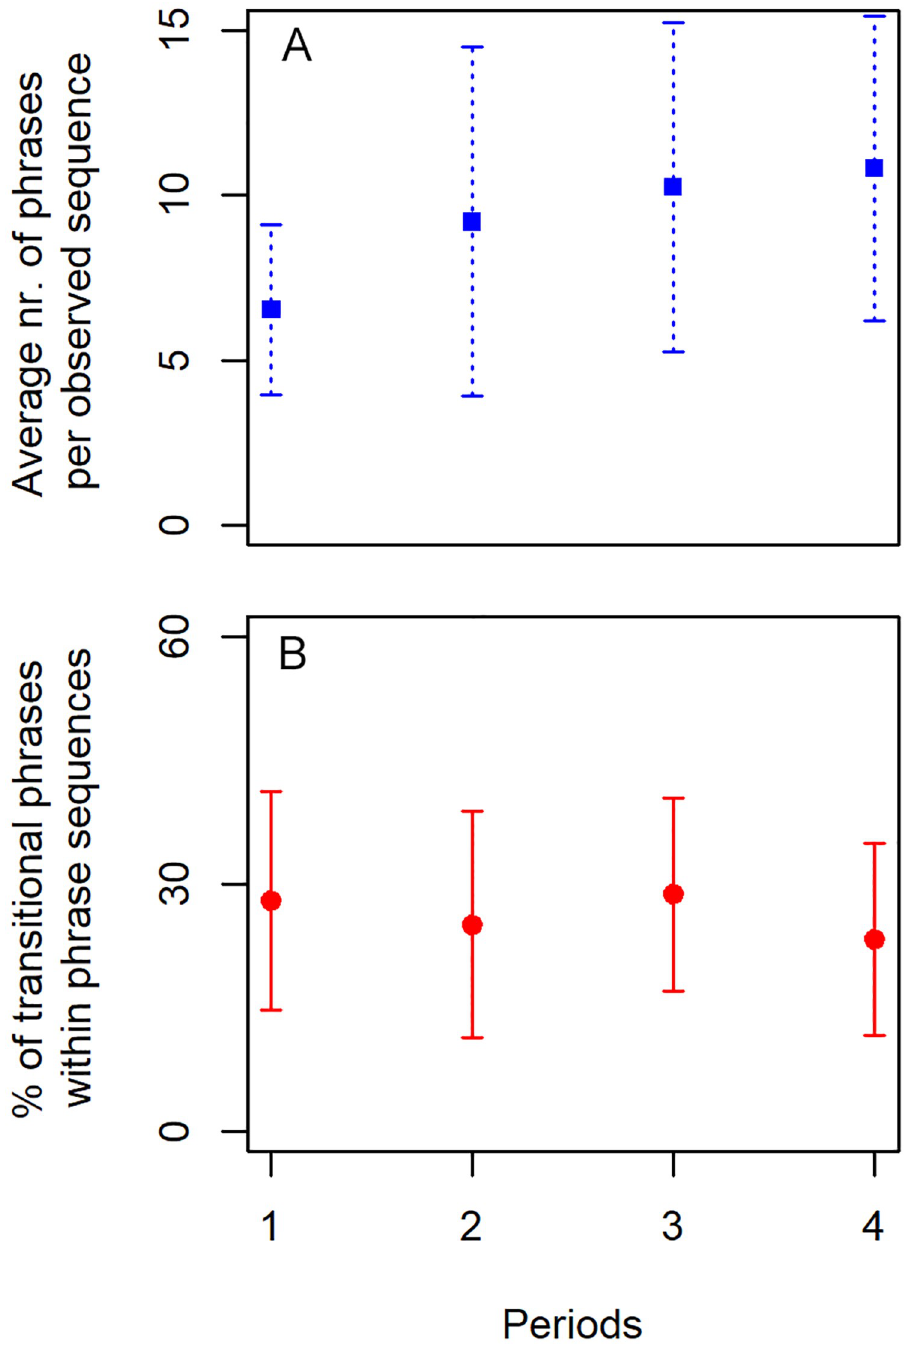
Fig 5. Occurrence of phrases and transitional phrases. A) An increase in the length of the phrase sequences was observed when including all repeated phrases within the 10 minute recordings. Sequences with fewer than four phrases were not included in this dataset. B) The percentage of transitional phrases within the observed phrase sequences from period-1 to -4.